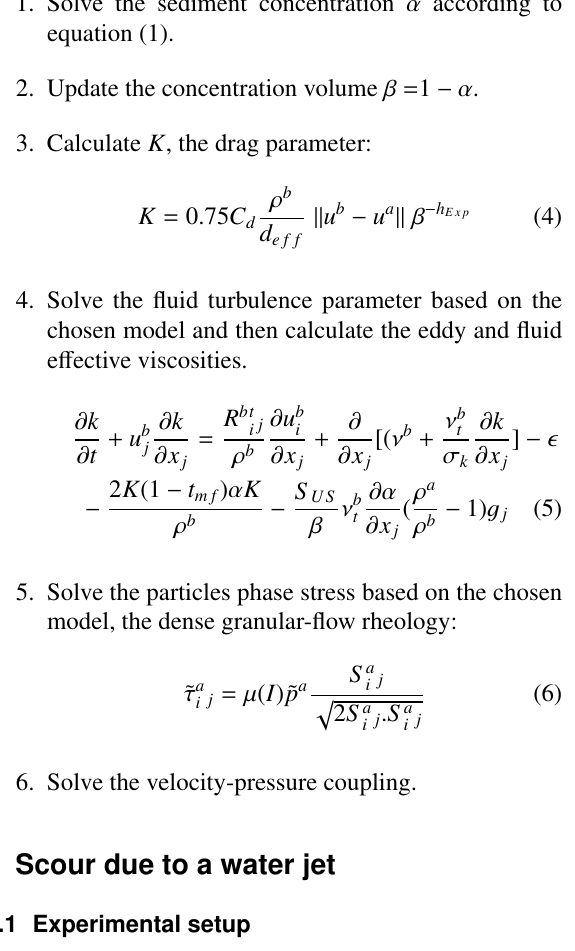
Figure 2: The digging-refilling (DR) regime, for b 0 = 1 cm and Q = 10 l / min